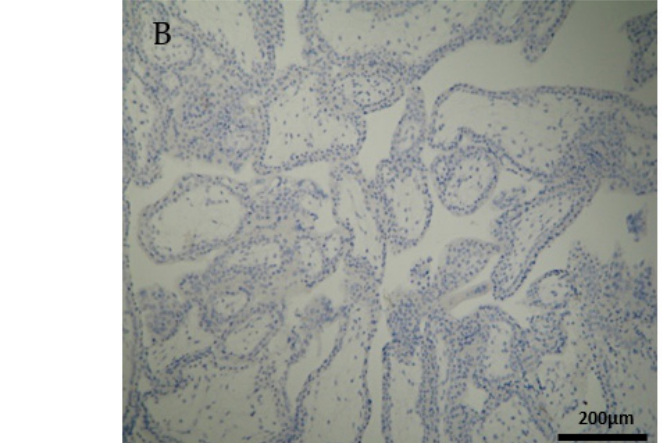
Figure 5 . Evaluation of positive CD8 antigen expression. Miscarriage experimental group (EG): ( Α ) Moderate expression of CD8 in the DP (4 × 10 magnification). ( Β ) Negative expression of the CD8 antigen in the chorionic villi (trophoblast) (4 × 10 magnification).